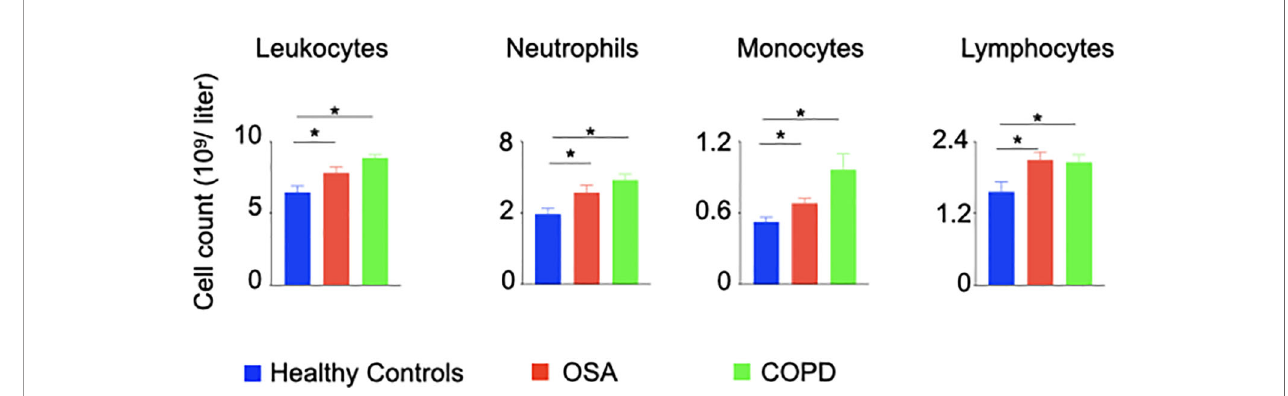
FIGURE 6 | Patients with hypoxia have elevated numbers of in fl ammatory leukocytes. A restrospective chart review was performed to enumerate in fl ammatory leukocytes in peripheral blood of patients with OSA and COPD. n = 26 (OSA), 10 (COPD) and 22 (Healthy controls). Data are shown as mean ± s.e.m. *P